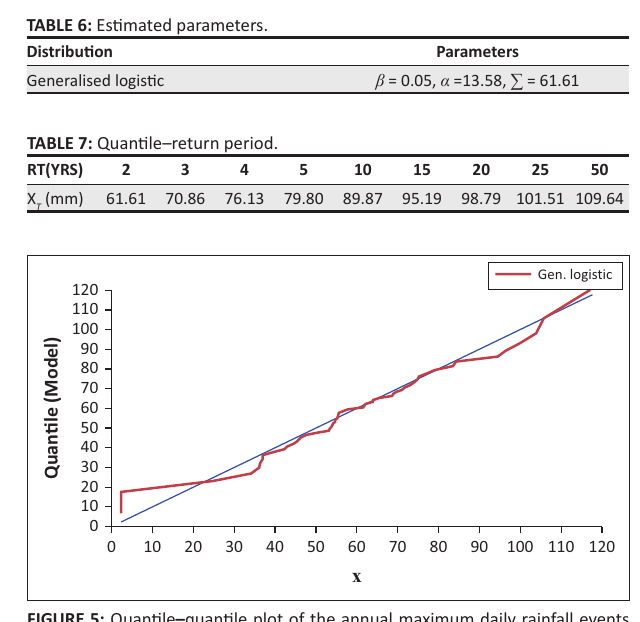
FIGURE 5: Quantile – quantile plot of the annual maximum daily rainfall events for Nelspruit (1961–2015).